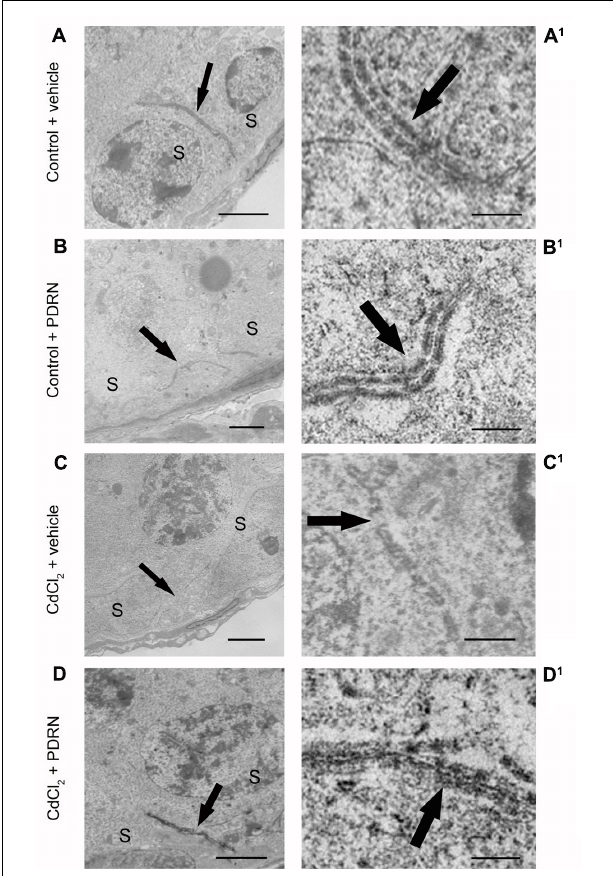
FIGURE 7 | Transmission electron micrographs of testes from control plus vehicle animals (A,A 1 ) , control plus PDRN (8 mg/kg i.p.) animals (B,B 1 ) , CdCl 2 (2 mg/kg i.p.) plus vehicle animals (C,C 1 ) , and CdCl 2 (2 mg/kg i.p.) plus PDRN (8 mg/kg i.p.) animals (D,D 1 ) . (A,A 1 ,B,B 1 ) Arrow, linear junctions between adjacent Sertoli cells (S). (C,C 1 ) Arrow, fragmented junctions between adjacent Sertoli cells (S). (D,D 1 ) Arrow, continuous junctions between adjacent Sertoli cells (S). [Scale bar: (A–D) = 4 µ m; (A 1 ,B 1 ) = 0.5 µ m; ( C 1 ) = 1 µ m; (D 1 ) = 0.3 µ